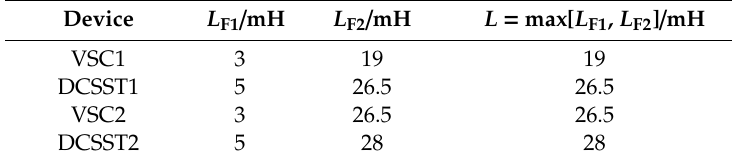
Table 4. Theoretical Calculation Results of Current Limiting Reactor for Per Pole.